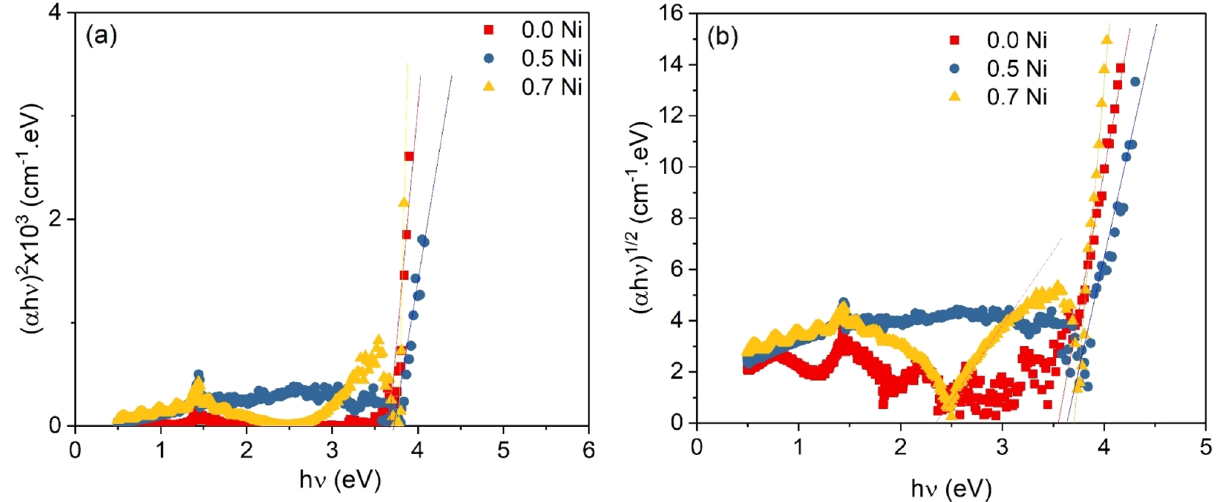
Figure 5. The relation between (αhν) 2 , (αhν) 1/2 , and hν respectively for the films of different Ni